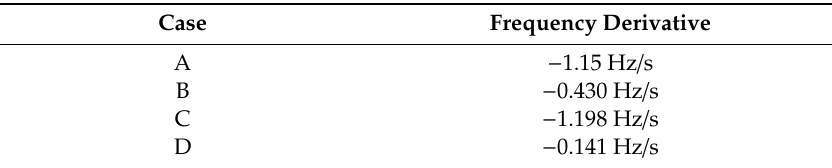
Table 2. Rate of frequency change at the first